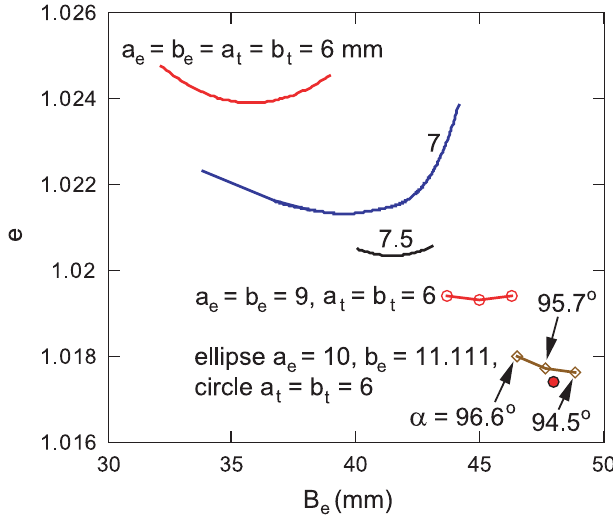
FIG. 12. (Color) Normalized electric field envelopes vs half-axis for the type b end cells. The single point is the final length B e